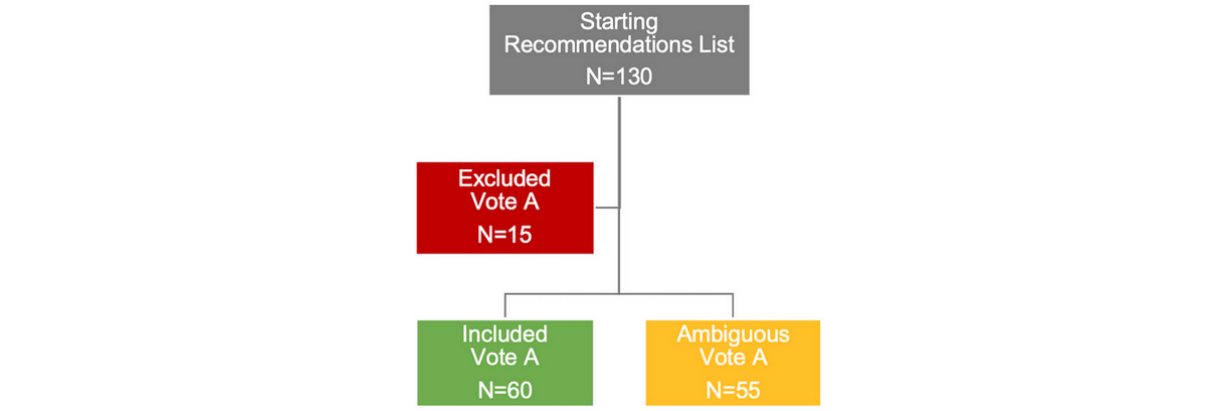
Figure 1. Results from vote